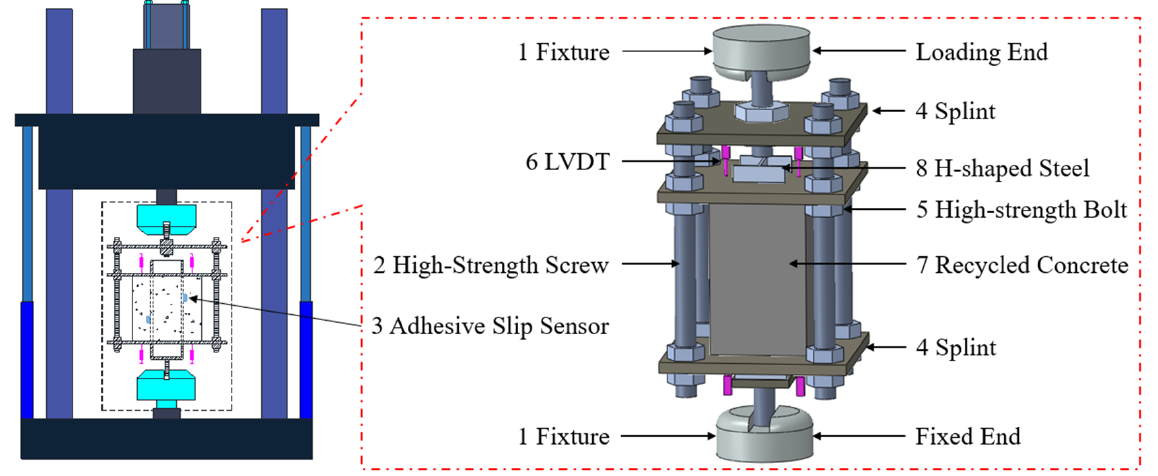
Figure 2. Test setup and loading specimen.